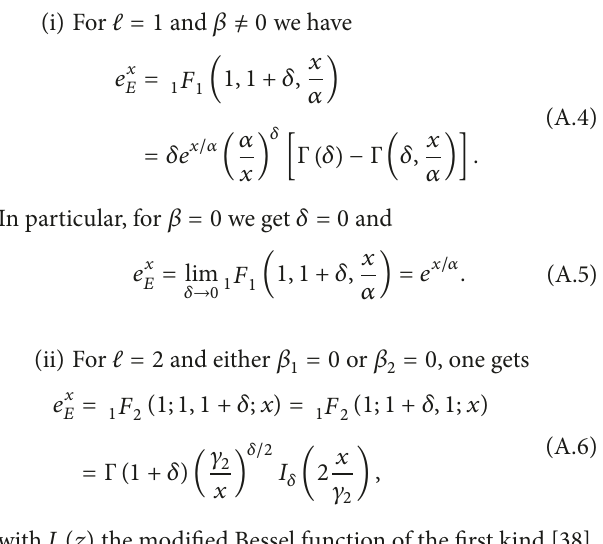
Figure 10: The normalized form of the correlation function of second order (54) for the horizontal and vertical output channels of a 50 :50 beam splitter injected by one of the SU (1, 1) coherent states |𝑧 ⟩ defined in 퐸